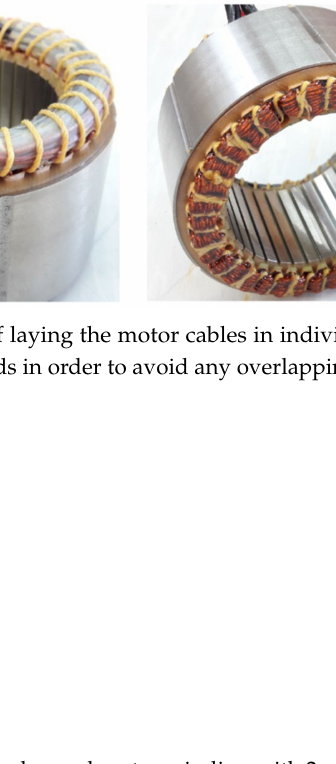
Figure 9. Example of a layered motor winding with 2 parallel wires per winding